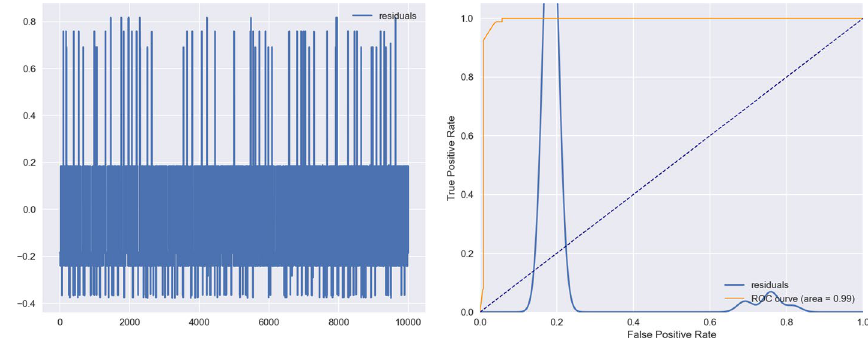
Fig. 6 Results of applying XGBoost to D34 only. Left: residual sequence with original timed order. Right: ROC curve and residual distribution